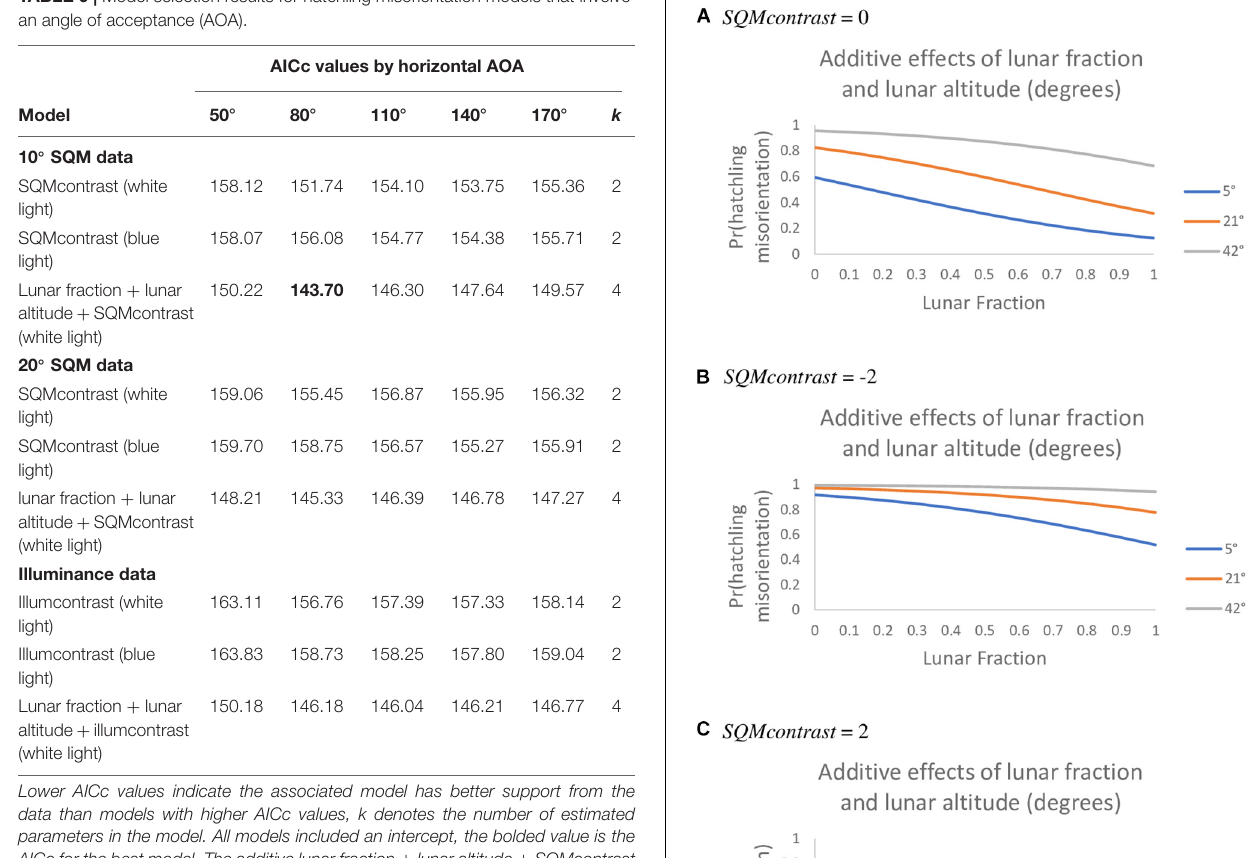
TABLE 6 | Model selection results for hatchling misorientation models that involve an angle of acceptance (AOA). AICc values by horizontal AOA